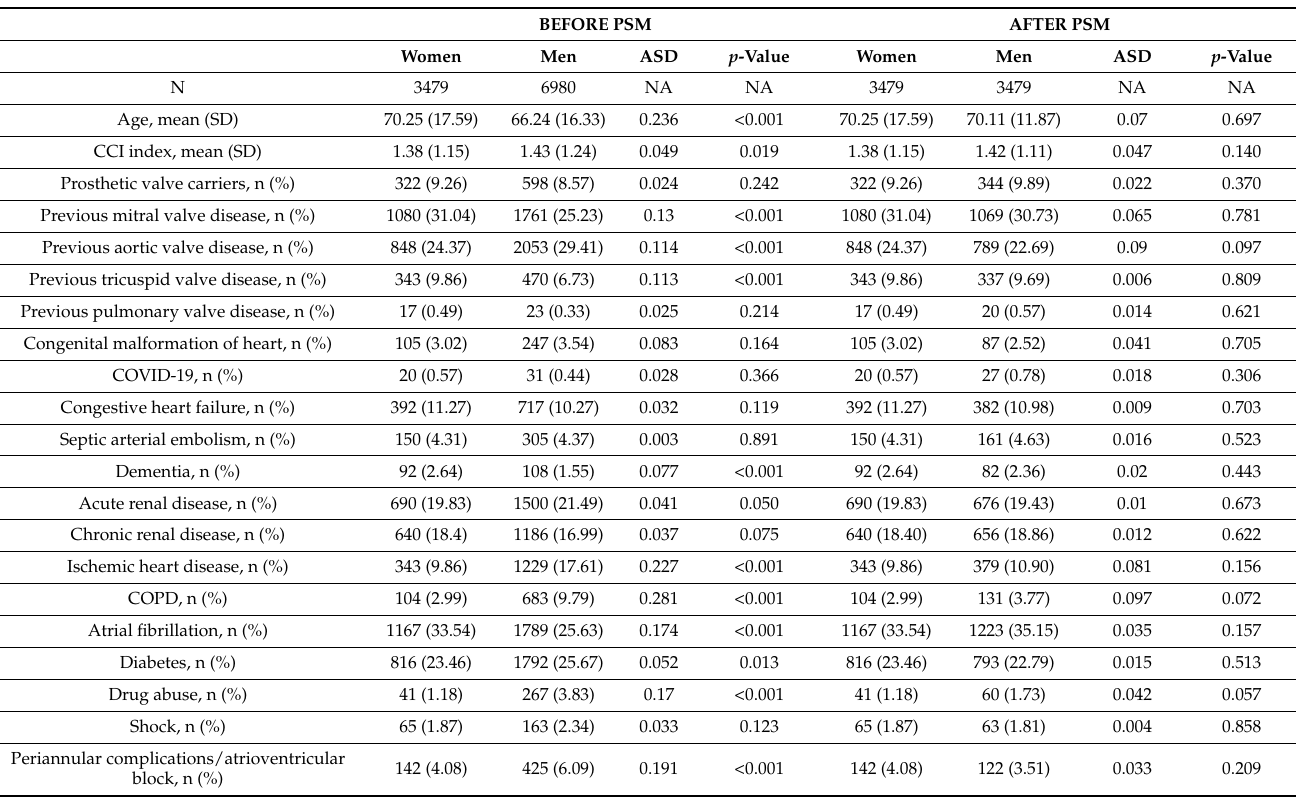
Table 2. Distribution of clinical characteristics of women and men with infective endocarditis in Spain (2016–20), before and after propensity score matching